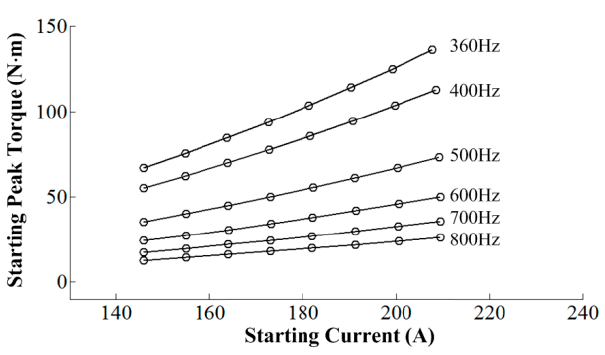
Figure 5. Fitting curves of starting peak torque. Table 2. Starting peak torque coefficient.